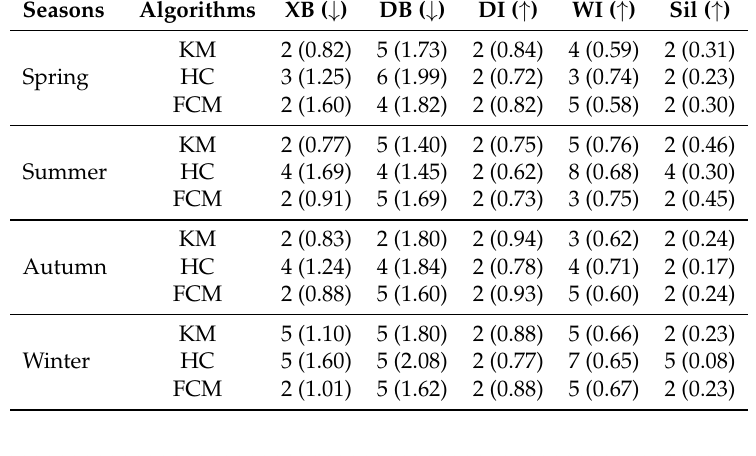
Table 2. Selected n c (with respective clustering validity index (CVI) score), for each algorithm and season. DB, Davies and Bouldin’s index; DI, Dunn’s validity index; WI, weighted average intra-inter cluster distance index; Sil, silhouette.